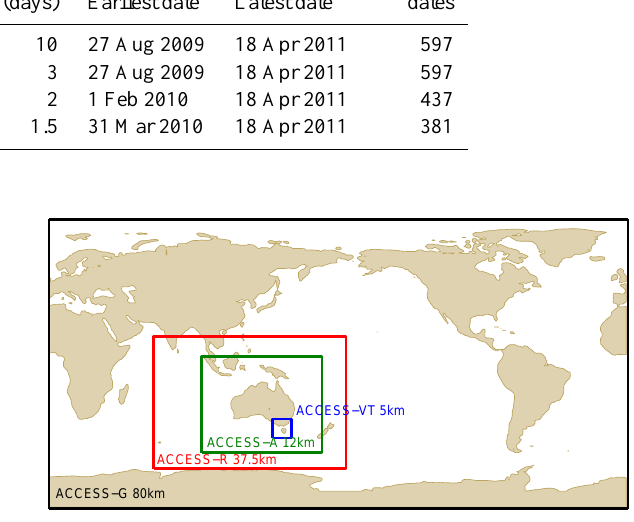
Table 1. Precipitation forecasts available from NWP models for the study. Resolution Lead time Forecast Domain